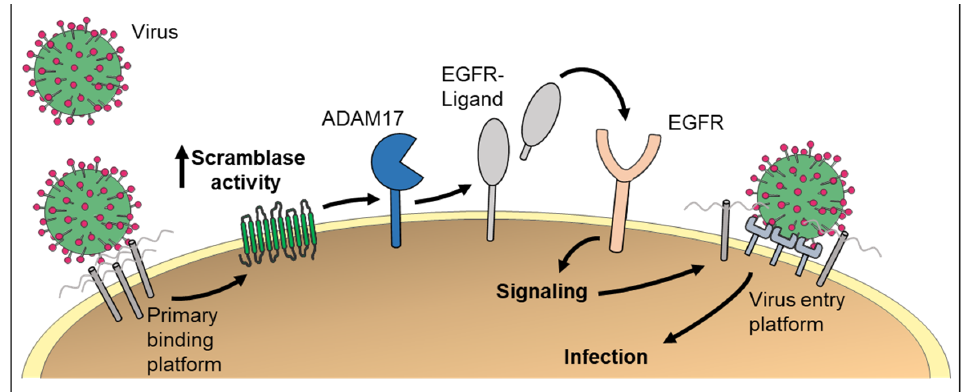
Figure 3. PS externalization could be of high relevance for virus entry into host cells. First, formation of the primary virus–receptor complex triggers non-apoptotic cell surface exposure of PS via scramblases. Externalized PS promotes membrane fusion and virus infection. Second, scramblase activation would lead to ADAM activation. Subsequent EGFR signaling has been identified as important step for infection with the human papillomavirus.